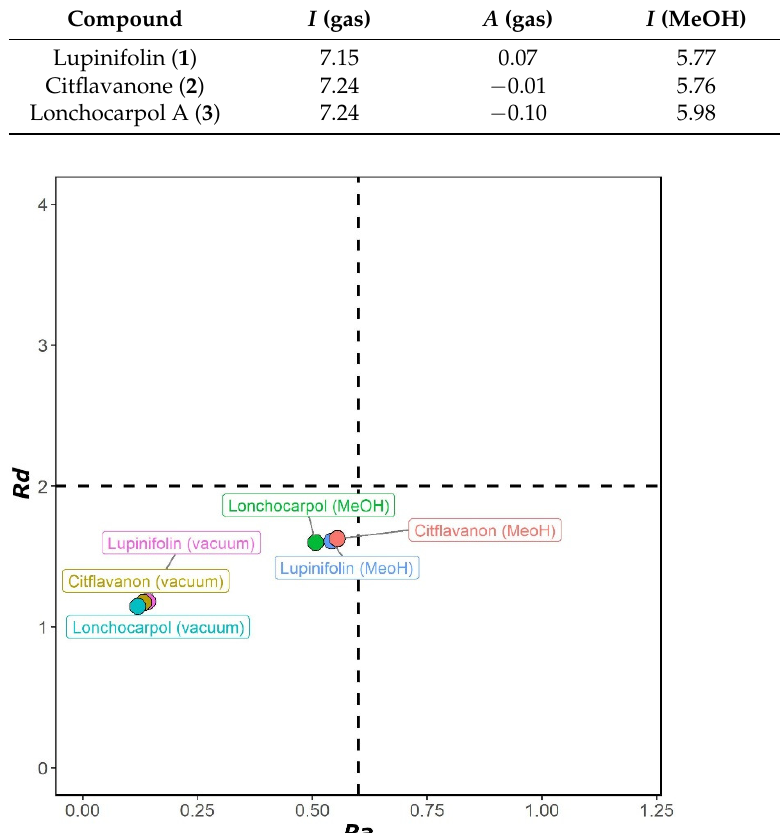
Figure 4. DAM for flavanones ( 1–3 ) in the gas phase and implicit methanol solvent (Table S1).